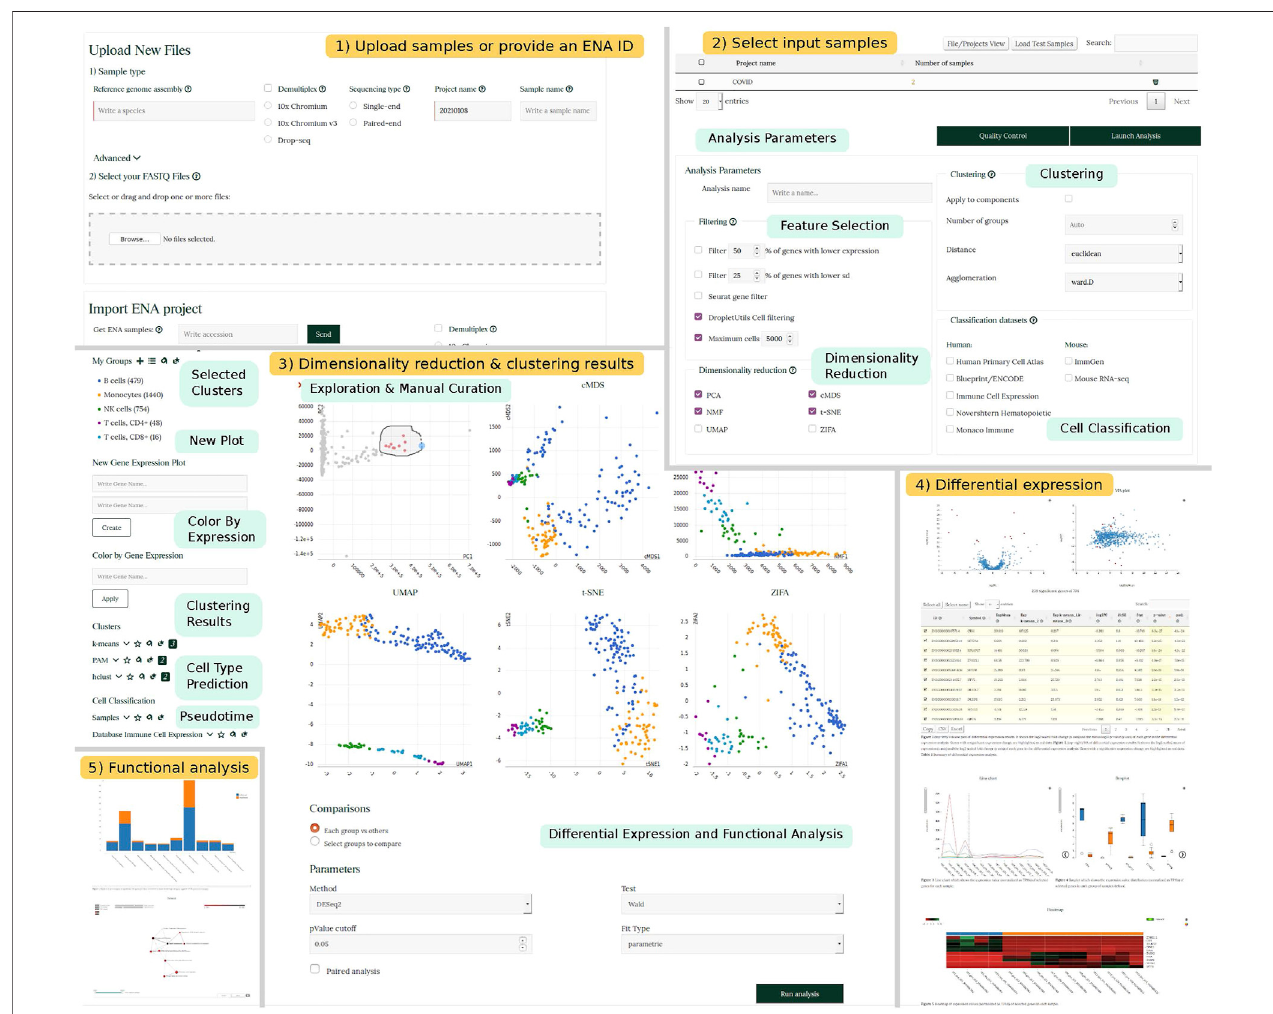
FIGURE 1 | SingleCAnalyzer Work fl ow. Schematic representation showing SingleCAnalyzer work fl ow example. Panel 1 and 2 show the web interface for setting input fi les and parameters. Panel 3 shows an example of visualization of dimensionality reduction, cellular type classi fi cation, pseudotime analysis and clustering results. Panels 4 and 5 show selected sections of differential expression and functional analysis